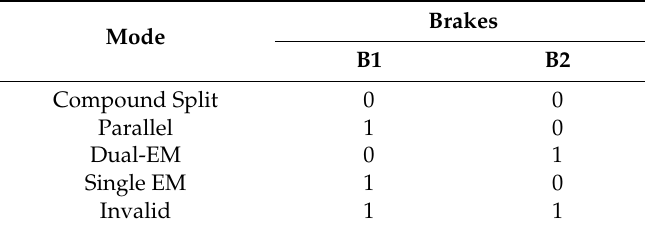
Table 2. Brakes states and corresponding